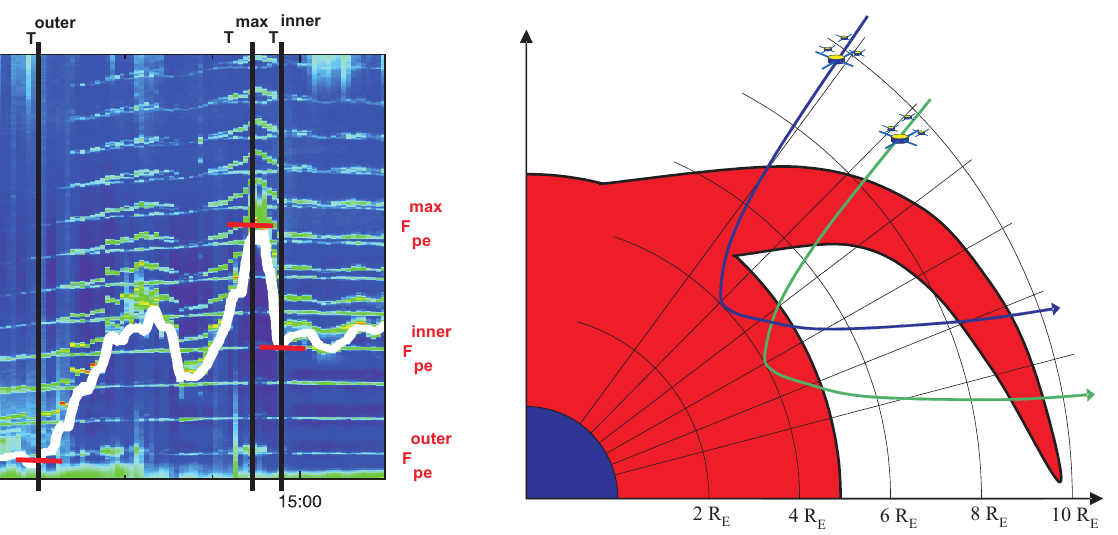
Fig. 3. Sketch of the crossing of a plasmaspheric plume by a Cluster satellite, projected onto the equatorial plane in a co-rotating frame. The green and blue lines represent two different trajectories and the red shape sketches the plasmasphere with a